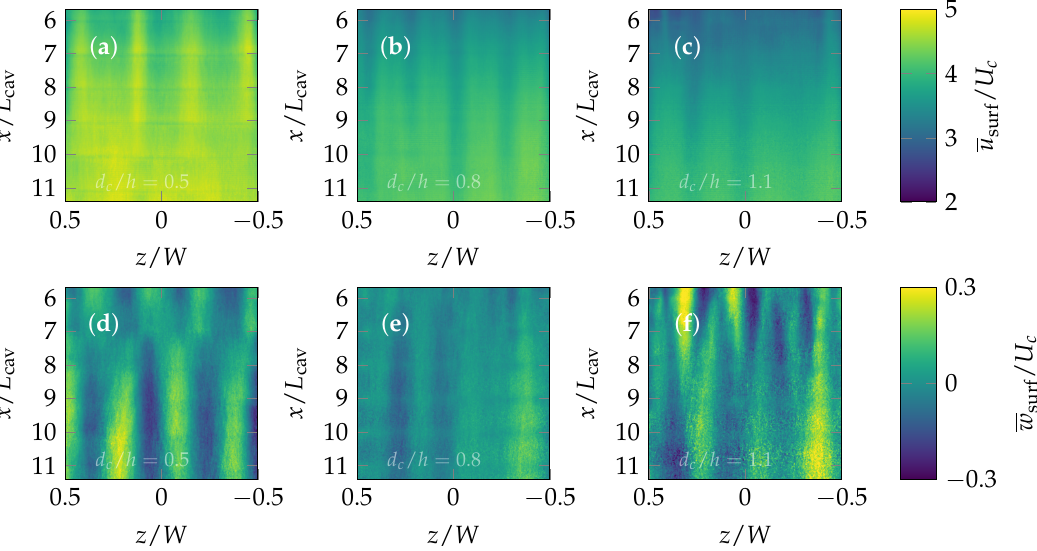
Figure 5. Streamwise ( u surf ) and transverse ( w surf ) free-surface velocities estimated from a top-view perspective for d c / h = 0.5, 0.8, and 1.1, normalized with the critical velocity U c = verse